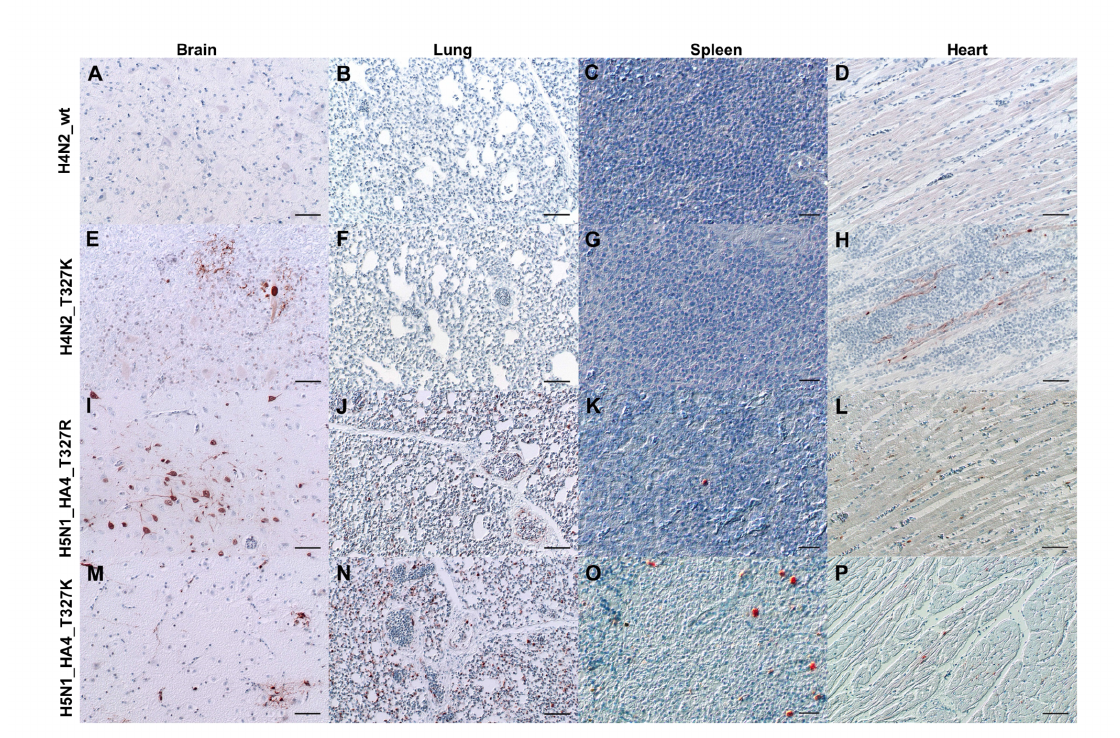
Figure 7. Distribution of avian influenza virus NP in selected organs of inoculated birds. Distribution of influenza NP in brain ( A , E , I , M ), lung ( B , F , J , N ), spleen ( C , G , K , O ) and heart ( D , H , L , P ) of inoculated chickens of selected viruses at 4 dpi (except for H5N1_H4_T 327 K) as detected by immunohistochemistry using primary polyclonal rabbit anti-NP A / FPV / Rostock / 34 antibody (1:750) and a secondary biotinylated goat anti-rabbit IgG (Vector Laboratories, Burlingame, CA, USA) antibody (1:200). 3-amino-9-ethyl-carbazol (red-brown); hematoxylin counterstain (blue); Nomarski contrast; bars A,B,D,E,F,H,I,J,L,M,N,P = 20 µ m. Bars C,G,K,O = 50 µ